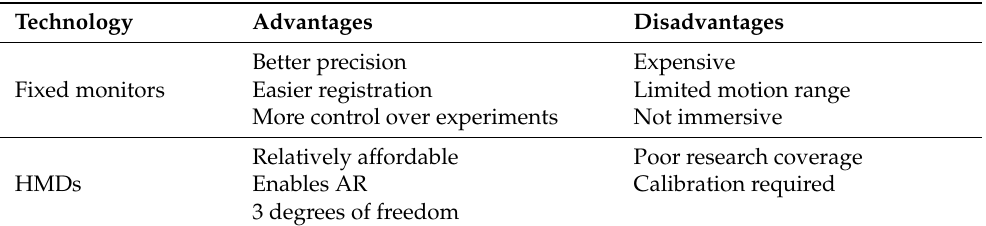
Table 5. A few of the advantages and disadvantages of static, flat monitors vs. head-mounted displays, in the context of the present review. Technology Advantages Disadvantages Better precision Expensive Fixed monitors Easier registration Limited motion range More control over experiments Relatively